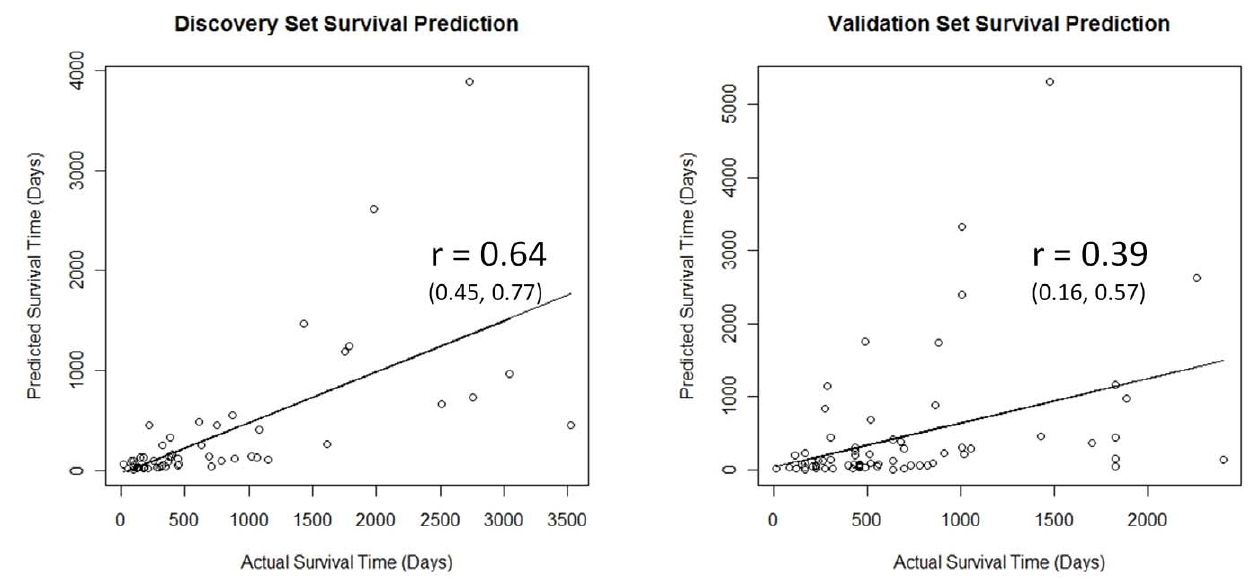
Figure 3. Graph of predicted and actual survival times in Proneural subtype for the discovery data set (left) and the validation data set (right) using the age-adjusted stepwise selection model (up to IFI44). The correlation between predicted and actual survival values is 0.64 (0.45, 0.77) in the discovery set and 0.39 (0.16, 0.57) in validation set.